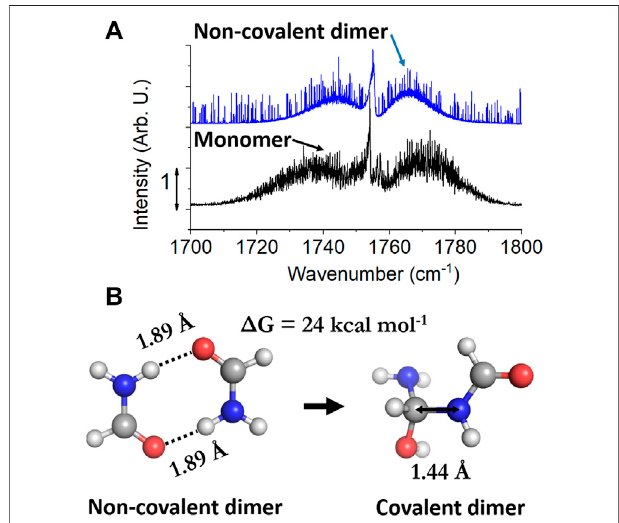
FIGURE 3 | Panel (A) Measured gas-phase spectrum of the ] 4 absorption bands of monomeric and non-covalent dimeric formamide formed by thermolysis in the presence of iron-rich smectite. The covalent formamide dimer is not detected. Panel (B) An indication of a quantum-chemically